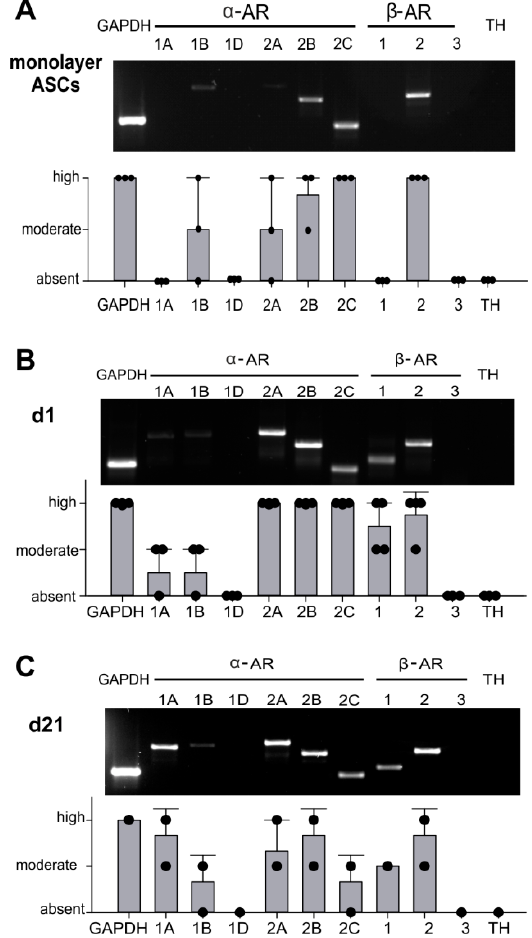
Figure 2. Adrenoceptor (AR) and tyrosine hydroxylase (TH) gene expression of sASCs in monolayer and pellet cultures ( A ) RT-PCR of AR and TH gene expression profile in untreated sASC in monolayer culture and average score of AR and TH gene expression in sASCs from three different OA patients. ( n = 3, mean ± standard deviation). ( B ) AR and TH gene expression profile in untreated sASC in three-dimensional chondrogenic pellet culture at day 1 and average score of AR and TH gene expression in sASCs from four different OA patients. ( n = 4, mean ± standard deviation). ( C ) AR and TH gene expression profile in untreated sASC in three-dimensional chondrogenic pellet culture at day 21 of differentiation and average score of AR and TH gene expression in sASCs from four different OA patients. ( n = 4, mean ± standard deviation).